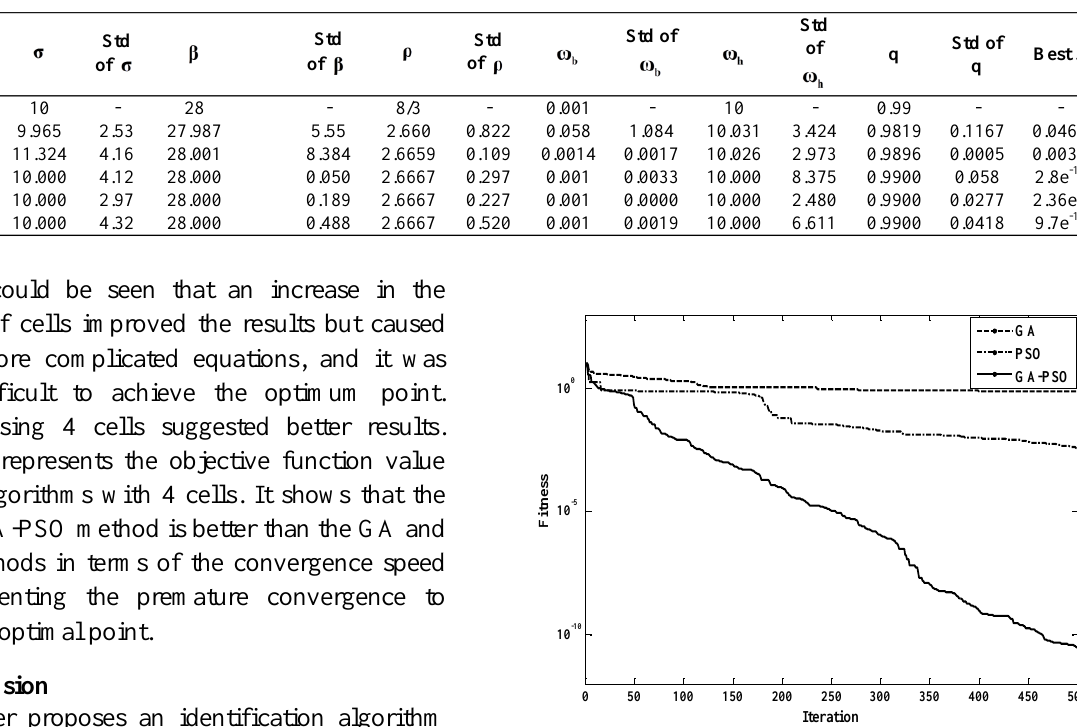
Table 3. Results obtained by PSO-GA method for parameter estimation of approximated fractional-order Lorenz system with 2, 3, 4, 5 and 6